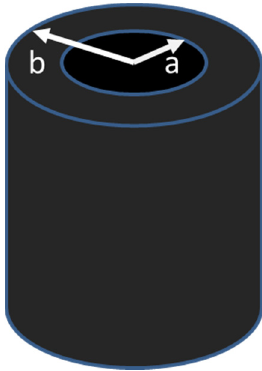
Figure 2. Hollow cylinder flywheel.